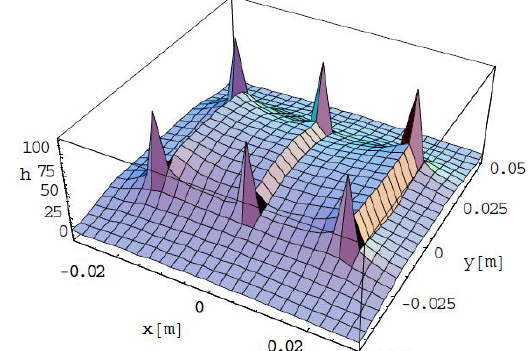
Fig. 6. Spatial distribution of the magnetic field modulus on the plane z = l /2 for the three-phase line of three ribbon busbars of finite length for asymmetric currents; l = 1 m, d = 0.02 m, b = 0.05